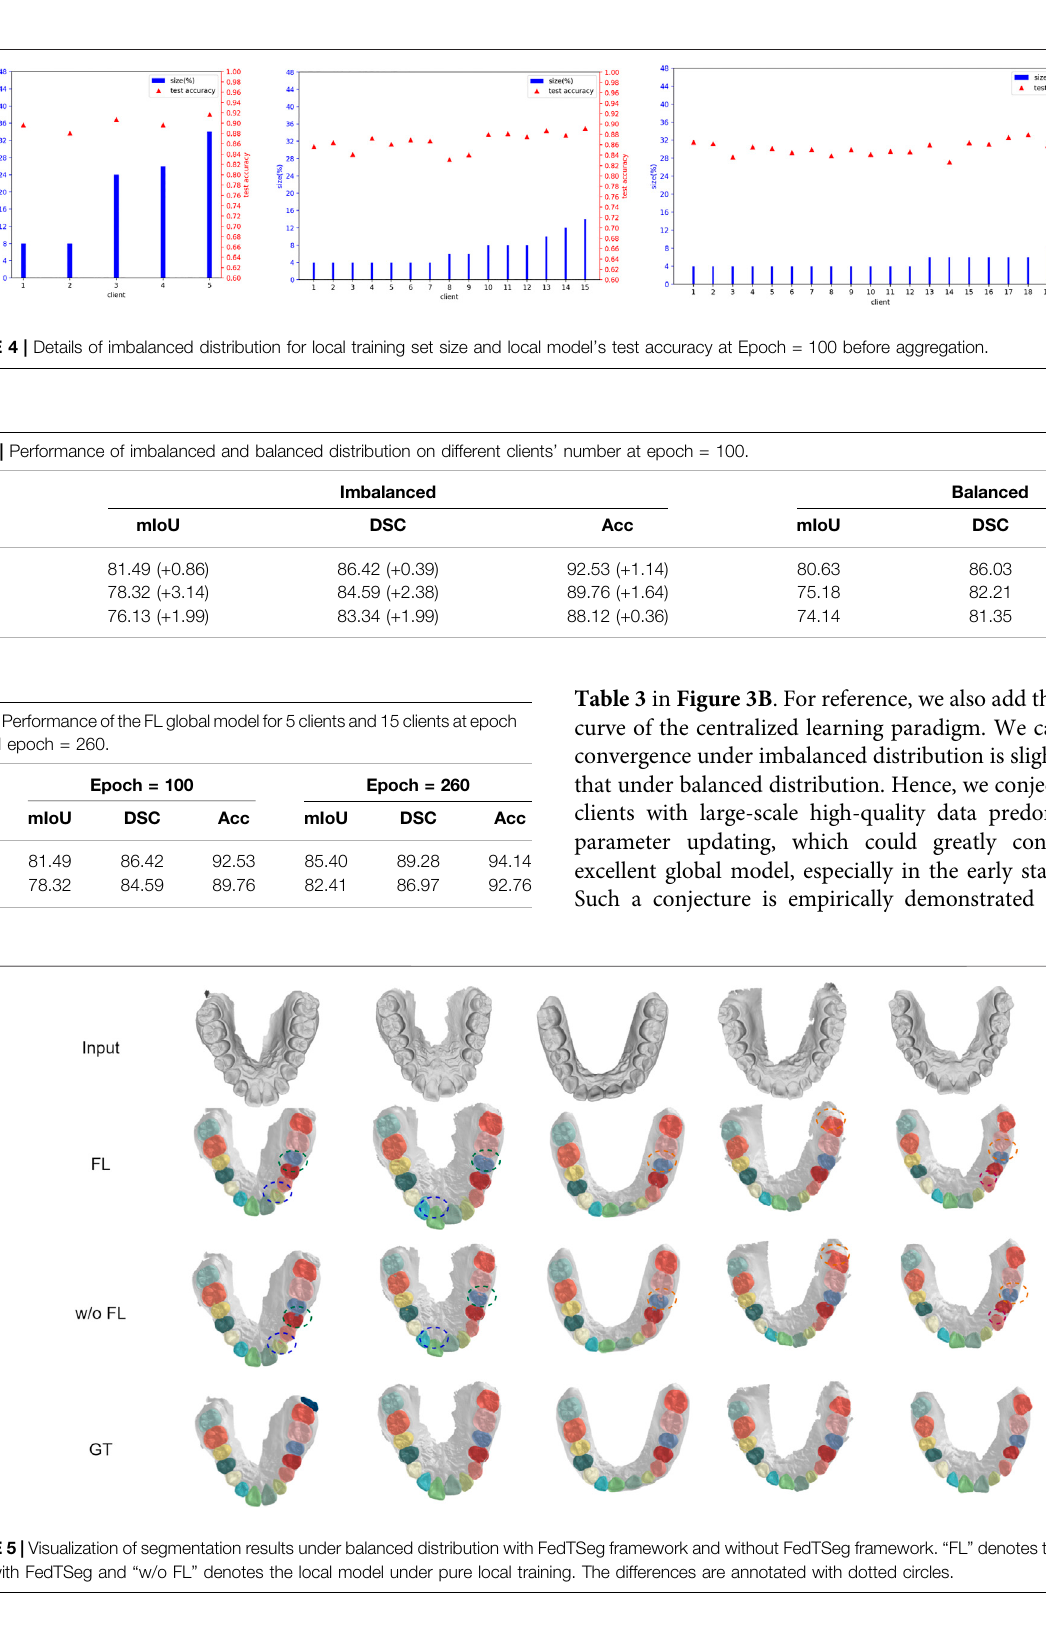
Frontiers in Communications and Networks |